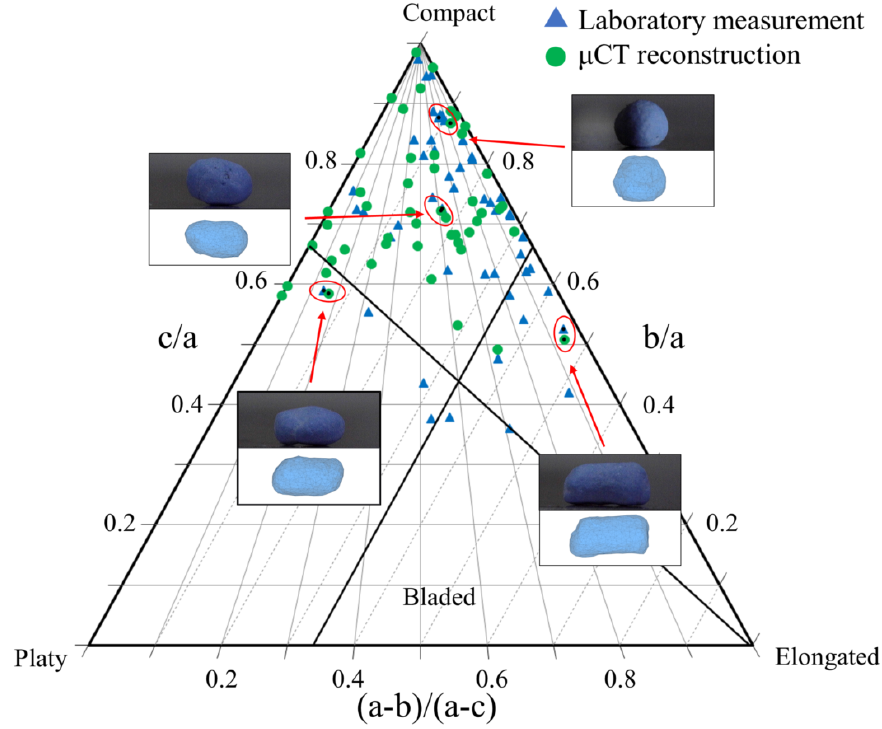
Figure 2. Classification of two groups of polymer–crystal composite particles based on triangular 2 classification diagram.